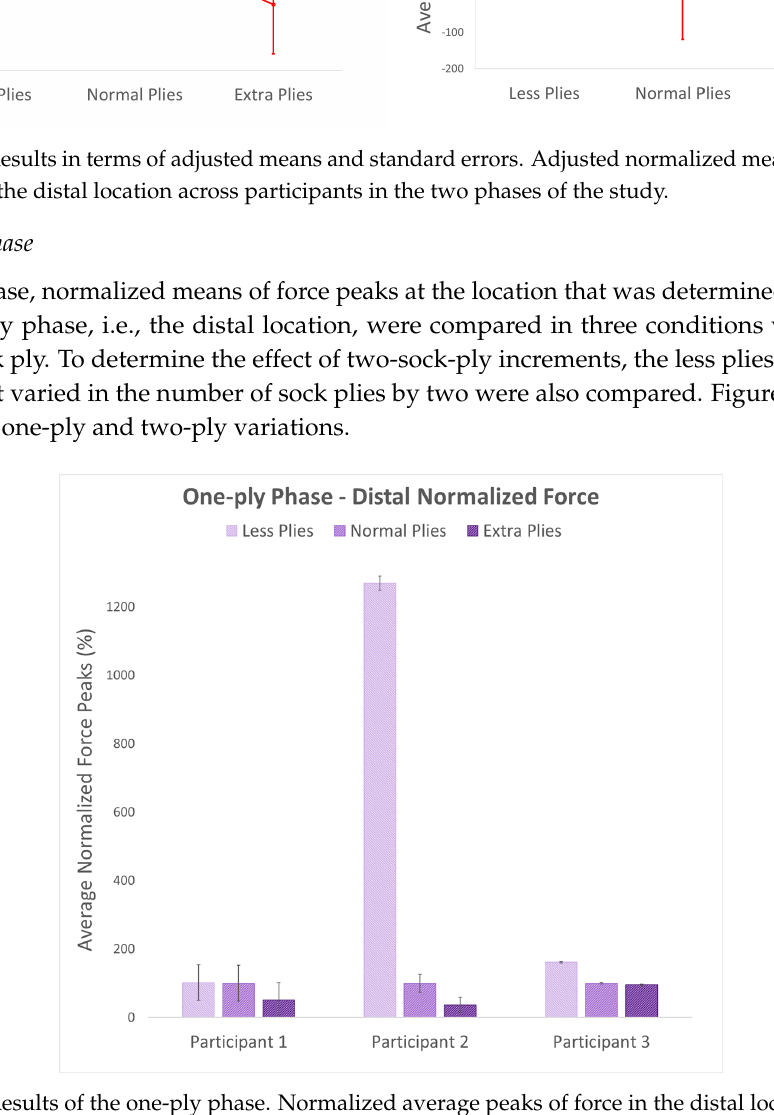
Figure 5. Results of the one-ply phase. Normalized average peaks of force in the distal location of the prosthetic sockets of the three participants in the one-ply